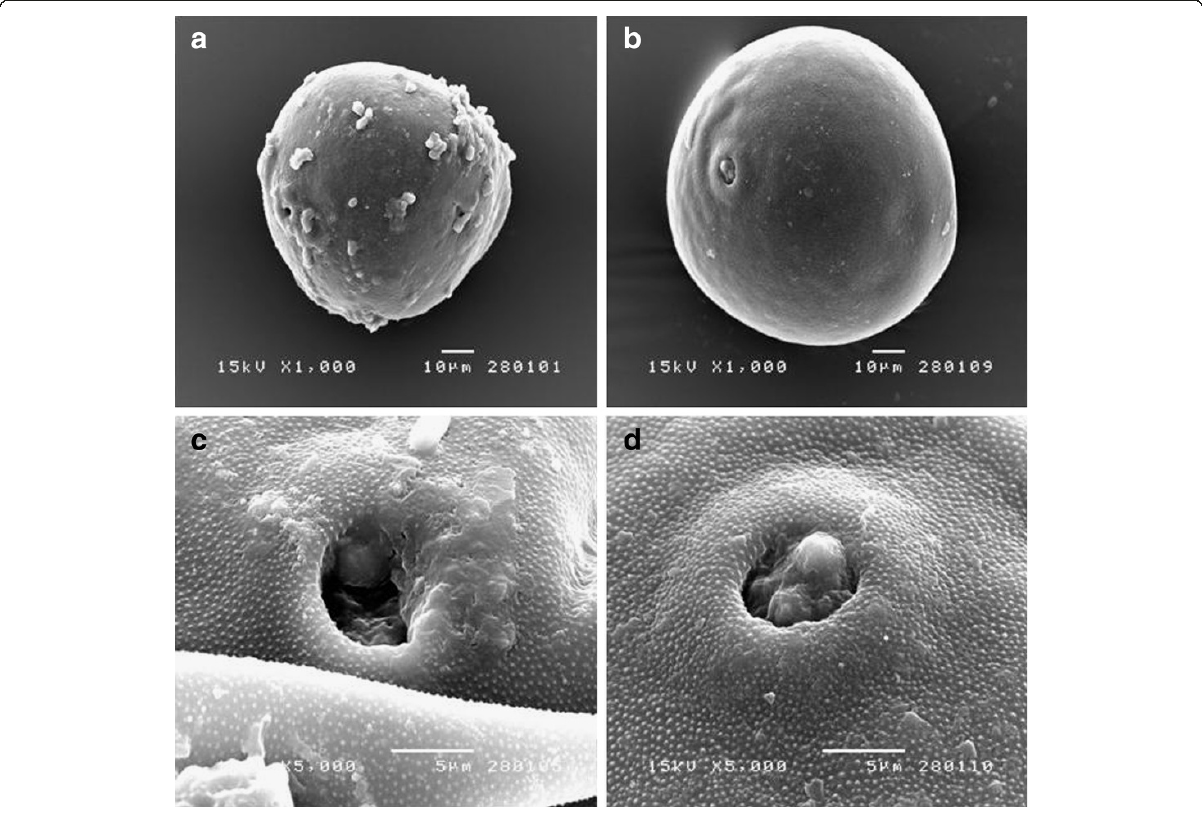
Figure 1 Comparison of the (A, C) A. mellifera harvested bee pollen with that of (B, D) corn pollen by SEM showing (A, B) the external morphology (1000 x magnification) and (C, D) the germination pore and ornamentation of the pollen exine (5000 x magnification). Micrographs shown are representative of those seen from 10 independent pollen